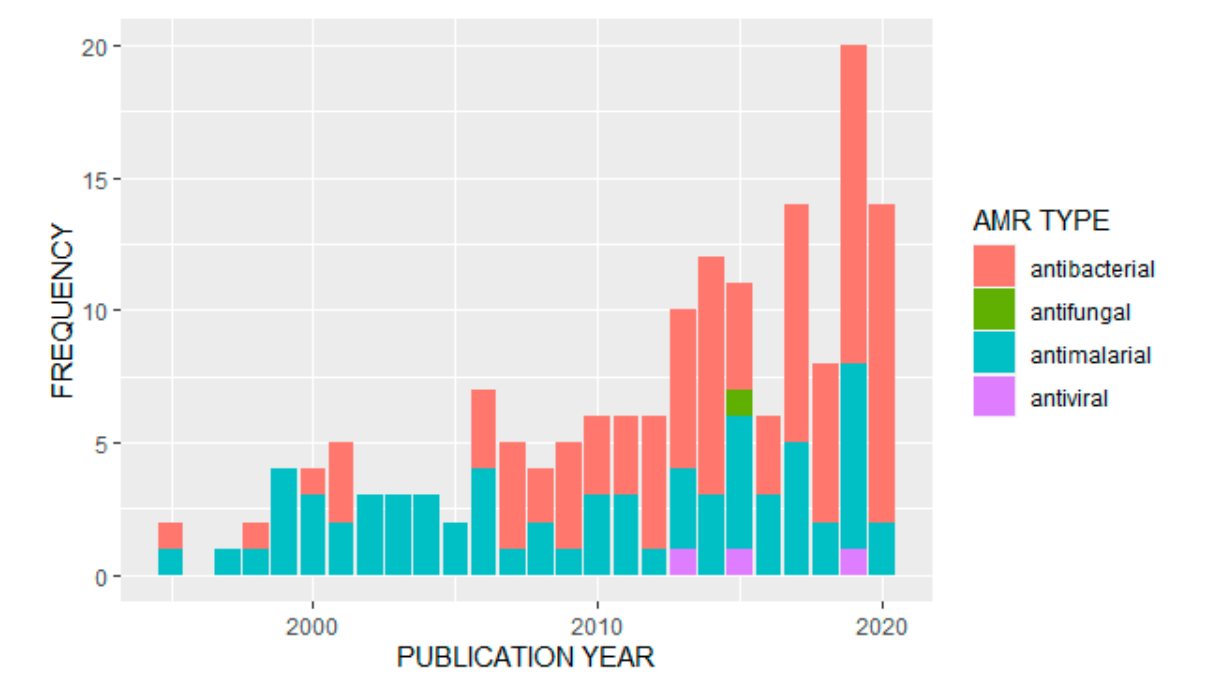
Figure 3. Distribution of studies on different AMR types by publication year.